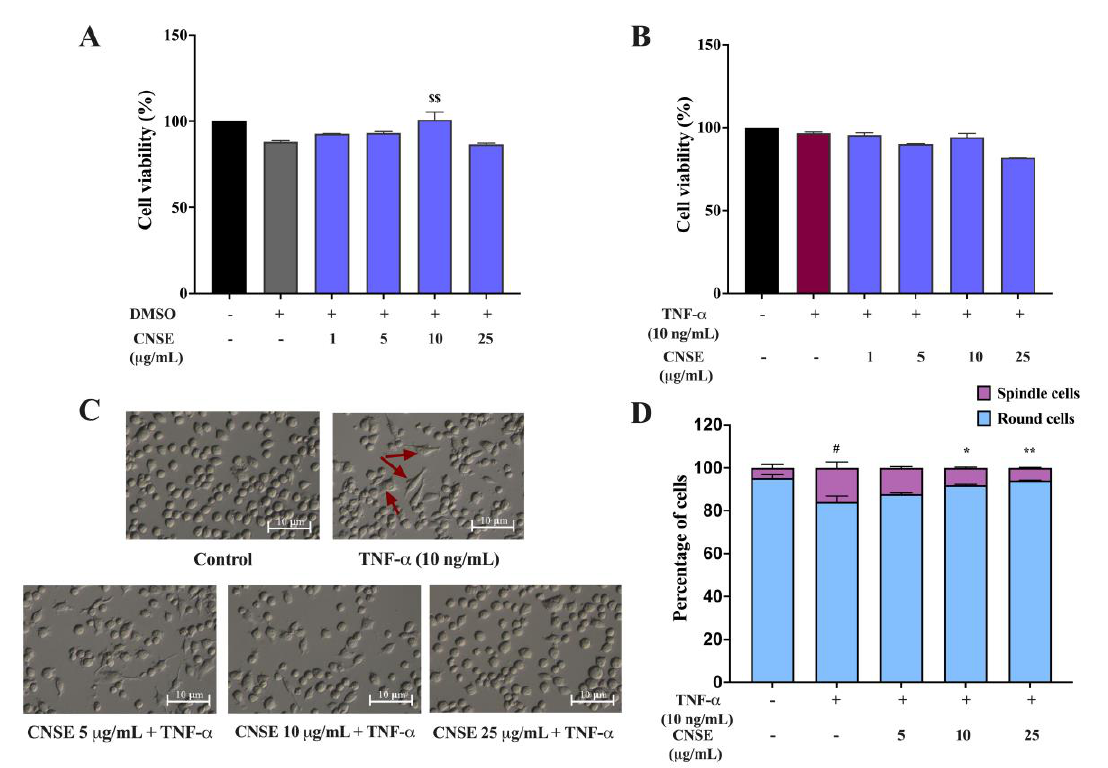
Figure 6. Effects of CNSE on cell viability and morphological phenotypes in BV-2 cells. Cell viability was determined using an MTT assay. For cytotoxicity assay, ( A ) BV-2 cells were incubated with various doses of CNSE for 24 h. Black color represents untreated control, grey color represents DMSO control and violet color represents CNSE treatment. ( B ) CNSE was pretreated for 24 h, followed by TNF- α for another 24 h. Black color represents untreated control, red color represents TNF- α group and violet color represents CNSE treatment. For morphological analysis. ( C ) Morphological phenotypes were captured using 10 × magnification of phase-contrast microscopy after pretreatment of cells with CNSE and TNF- α for 24 h. The red arrows represent the elongated cells. ( D ) The percentage of round and spindle cells is shown as a bar graph. Data are represented as the mean ± SD from at least three independent experiments. A p-value < 0.05 was considered to show a significant difference between each group ( $$ p < 0.01 vs. DMSO control; # p < 0.05 vs. untreated control;